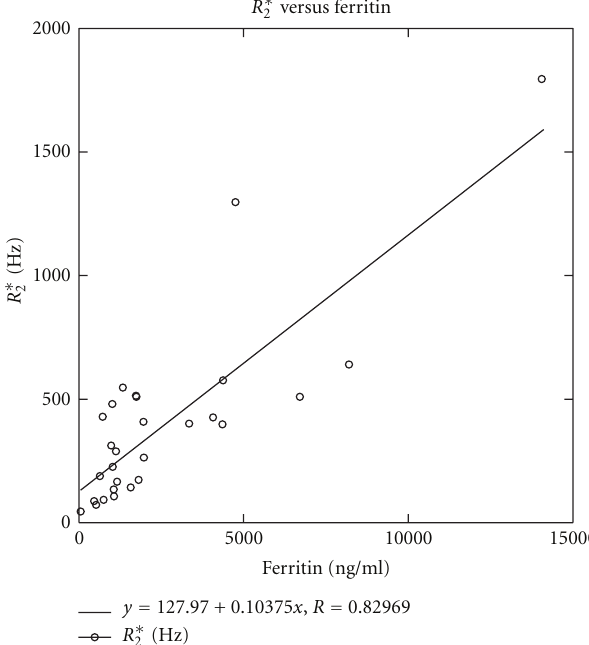
Figure 7: Scattergram of R ∗ 2 values calculated from MEGE MRI acquisition versus serum ferritin values. A good correlation between R ∗ 2 and ferritin is clearly